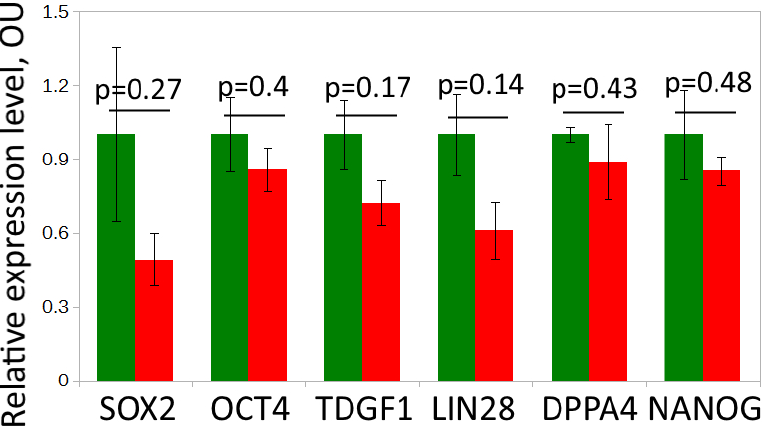
Figure 2. Analysis of the mRNA expression levels of OCT4, SOX2, NANOG, LIN28, DPPA4, and TDGF1 in lines iPS-KYOU (green) and iPS-DYP (red). Two biological repeats were performed. Housekeeping genes C1ORF43 and REEP5 were used for the normalization of the qRT-PCR data.